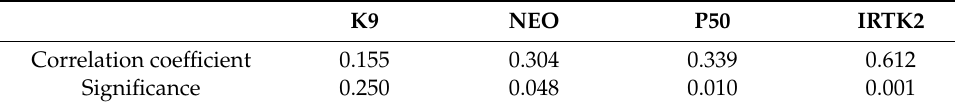
Figure 7. The number of available satellites with different canopy openness. Note: different letters in the figure indicate significant differences. Table 2. Correlation of canopy openness to the number of available satellites.